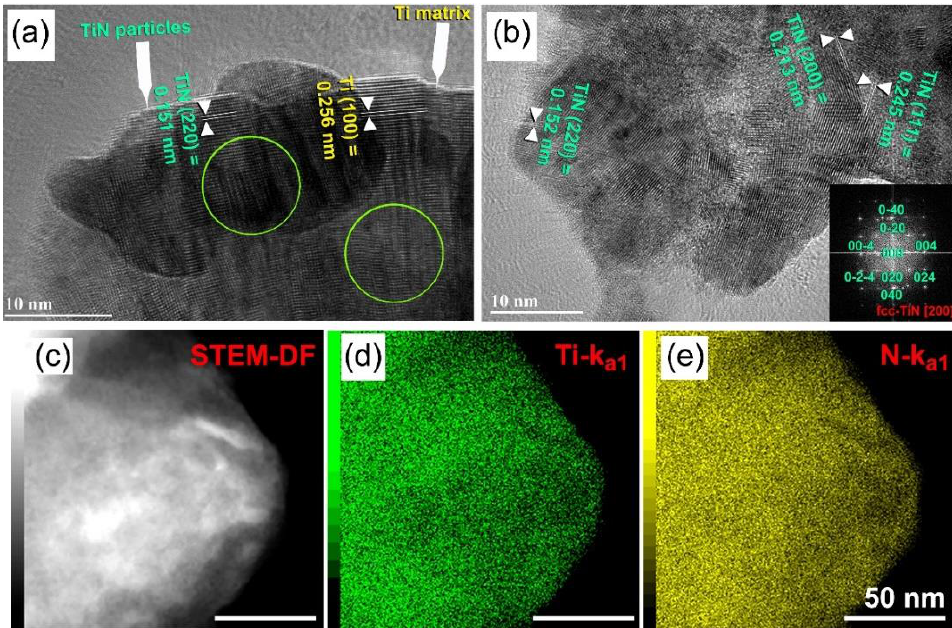
Figure 30. HRTEM image of samples after ( a ) 6 h, and ( b ) 20 h. The FFT of the circle chosen in ( b ) is presented as an inset of ( b ). STEM-DFI images of the powders produced after 20 h of RBM are presented in ( c ), while the matching EDS maps of elemental Ti and N are shown in ( d ) and ( e ).